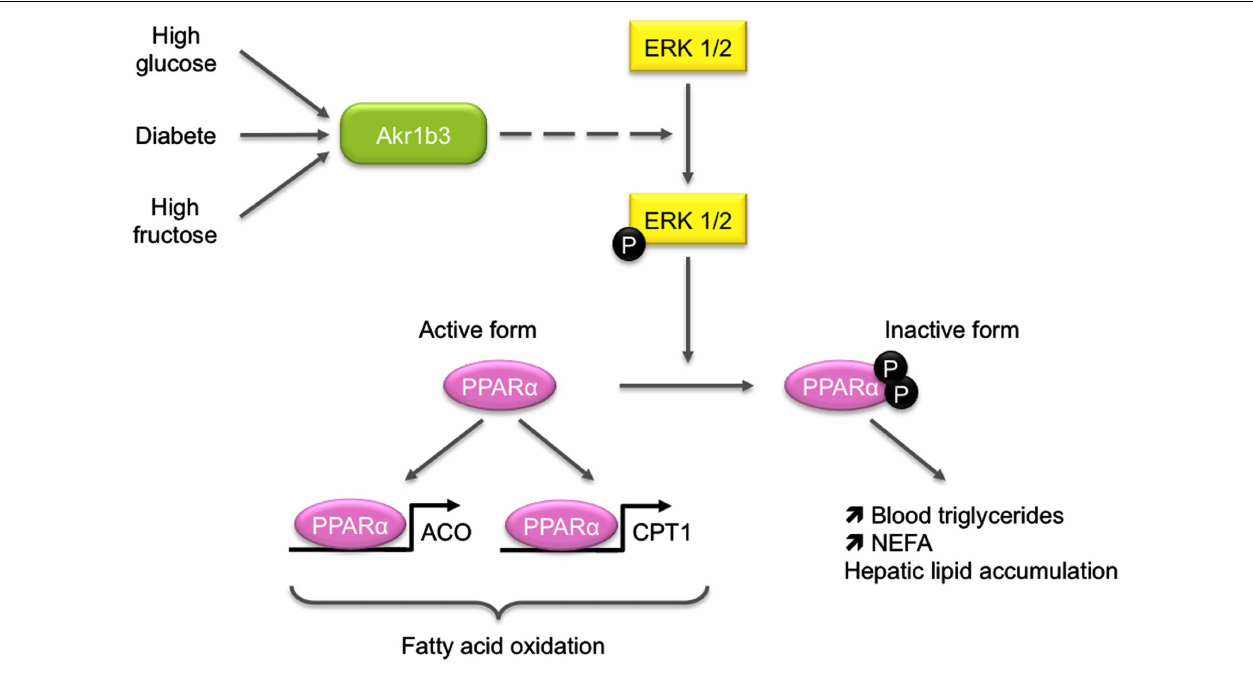
transcriptional activity resulting in down-regulation of β -oxidation master genes. Impaired β -oxidation favors hepatic lipid accumulation and increases blood triglycerides and non-esterified fatty acids (NEFA).The mechanism by which Akr1b3 induces ERK1/2 phosphorylation is still unknown (dashed